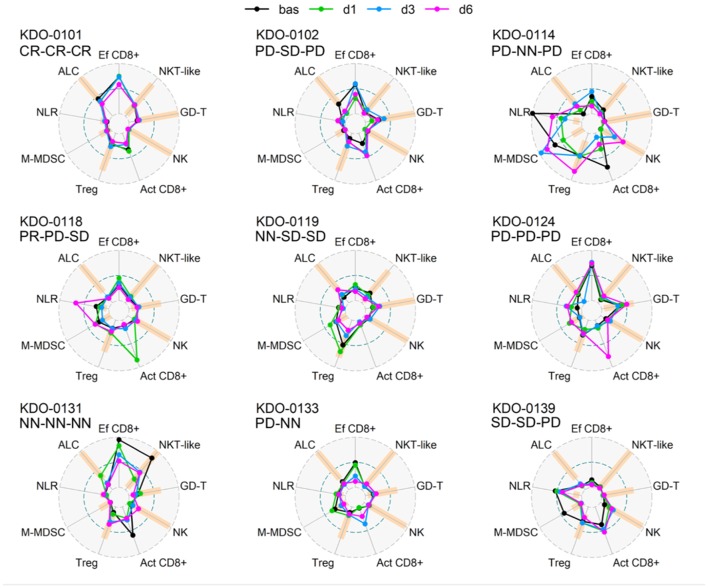
Peripheral blood immunograms of dendritic cell (DC)-treated sarcoma patients. Nine circulating immune parameters are radially arranged with reference ranges shown in orange. Parameters are scaled according to numbers achieved within the entire study group of nine patients. Outer circle (OC, gray dashed) represents the upper limit of the reference range for ALC, NK cells, NKT-like cells, GD T-cells, maximum number reached for the particular marker for Tregs, M-MDSC, and NLR or 100% for Ef CD8+ and Act CD8+; small inner circle (IC, gray dashed) represents zero level; middle circle (MC, pacific blue dashed) represents 50% of OC level. Particular levels are listed for each parameter as follows. ALC, absolute lymphocyte count (reference range1 10–16 years 1.4–4.2 × 106/ml, >16 years 1.2–4.1 × 106/ml; OC: 4.2 106/ml); NLR, neutrophil-to-lymphocyte ratio (reference range2 1–3; OC 19.9); Ef CD8+, circulating effector cytotoxic T-cells (CD27−/CD8+; % of CD8+ T-cells) (OC: 100%); Act CD8+, activated cytotoxic T-cells (HLA-DR+/CD8+; % of CD8+ T-cells) (OC 100%), NK cells (reference range1 10–16 years 4–51% of lymphocytes, >16 years 5–49% of lymphocytes; OC: 51% of lymphocytes); NKT-like, circulating CD3+CD56+ NKT-like cells (reference range1 10–16 years 0.64–15% of lymphocytes, >16 years 1–18% of lymphocytes, OC 18% of lymphocytes); GD-T, γδ T-cells (reference range1 10–16 years 2–17% of lymphocytes, >16 years 0.8–11% of lymphocytes; OC: 17% of lymphocytes); Treg, regulatory T-cells (reference range1 10–16 years 4–20% of CD4+ T-cells, >16 years 4–17% of CD4+ T-cells; OC: 25.3% of CD4+ T-cells); M-MDSC, monocytic myeloid-derived suppressor cells (reference range3 0–0.24 × 106/ml; OC: 0.98 × 106/ml). Baseline levels prior to DC ITx initiation are shown in black and levels at doses d1, d3, d6 are shown in shades of blue. Clinical outcome is shown for each subject at DC ITx initiation, at dose 5, at dose 9. Clinical outcome is abbreviated as follows: CR, complete response; PD, progressive disease; SD, stable disease; NN, non-CR/non-PD; NA, not available. 1Reference range originated from Schatorje et al. (12). 2Estimated from reference ranges for relative differential cell blood count. 3Our user-defined reference value, source group described in Pilatova et al. (13).